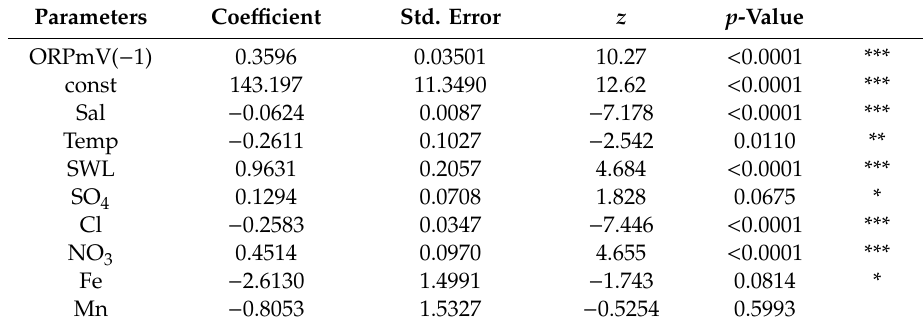
Table 5. Multiple regression statistical model with dependent variables against the Eh as independent variables for selected dry season hydrochemical parameters.